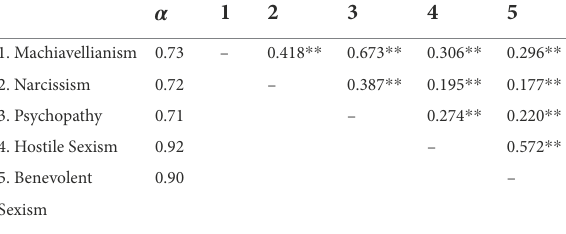
TABLE 3 Relationships between the dark triad of personality and ambivalent